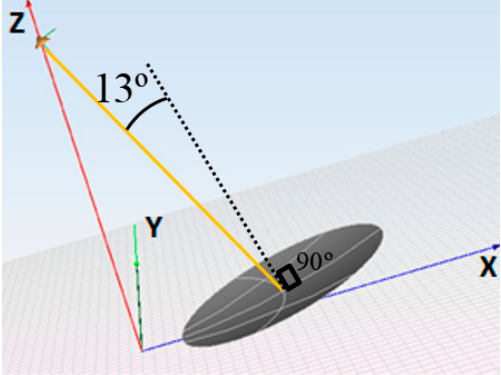
Figure 2. Scheme of offset parabolic reflector. The feed location and incident angle of the central element are shown.